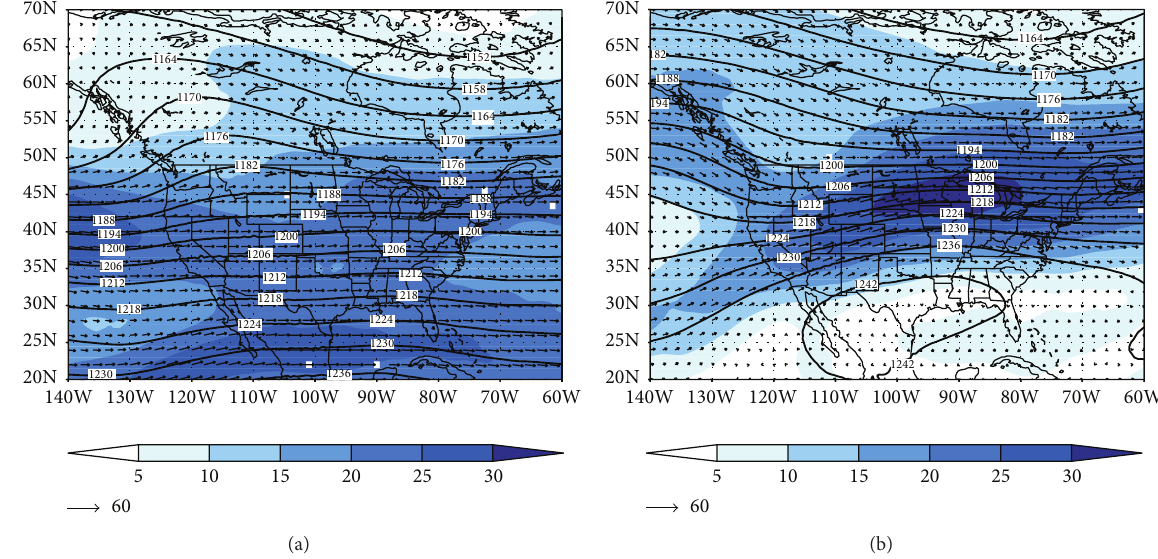
Figure 5: 200 hPa height (contour, decameters) and wind (contour and vector m/sec) for (a) AMJ93 and (b) JAS93. Data from CFSR.